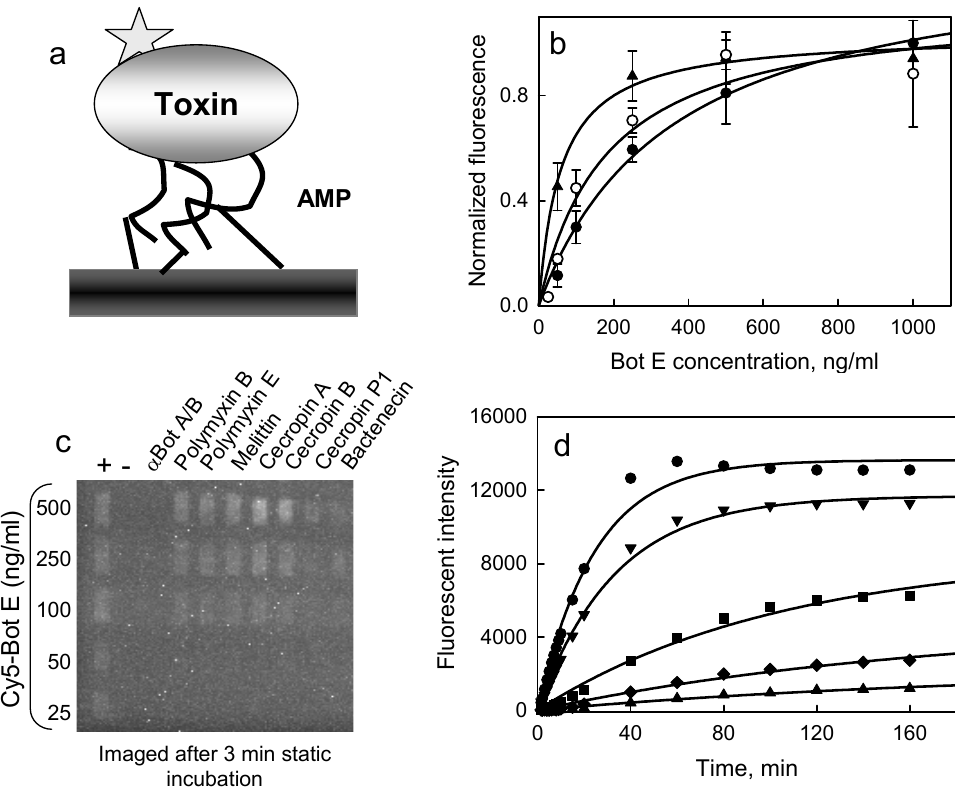
Figure 4 . Direct assays for botulinum toxoids using immobilized AMPs. Panel a: Schematic of direct assay used for kinetic determination; the toxin is shown labeled with fluorophore ( (cid:144) ). Panel b: Dose- response curve of Cy5-labeled inactivated neurotoxin E binding to immobilized cecropin A ( ▲ ), cecropin B ( ● ), and melittin ( ○ ). Error bars represent standard deviations (n ≥ 4 replicate array elements). Panel c: Representative image of labeled inactivated botulinum toxin E binding to an array patterned with multiple AMPs (toxoid concentrations shown to the left of the image). This image was taken 3 minutes after addition of the labeled toxoid and shows that binding of toxin occurs very rapidly. Panel d: Representative timecourse curves of various concentrations of labeled toxoid E binding to cecropin B; data were extracted from images taken at different incubation times (such as that shown in panel c). Shown are 1000 ng / ml ( (cid:122) ), 500 ng / ml ( ▼ ), 250 ng / ml ( (cid:132) ), 100 ng / ml ( (cid:141) ), and 50 ng / ml ( ▲ ) toxoid